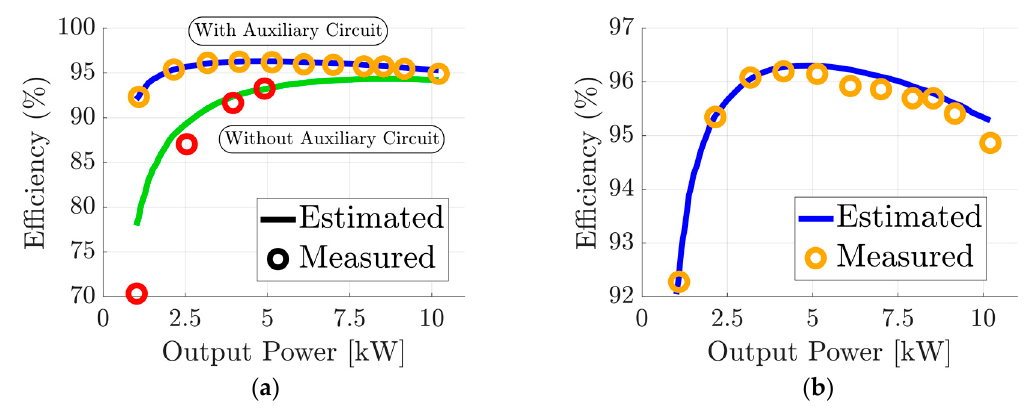
Figure 28. Experimental results: ( a ) efficiency at different output powers with (blue and yellow) and without (green and red) the auxiliary circuit, ( b ) close-up of the efficiency with the auxiliary circuit.